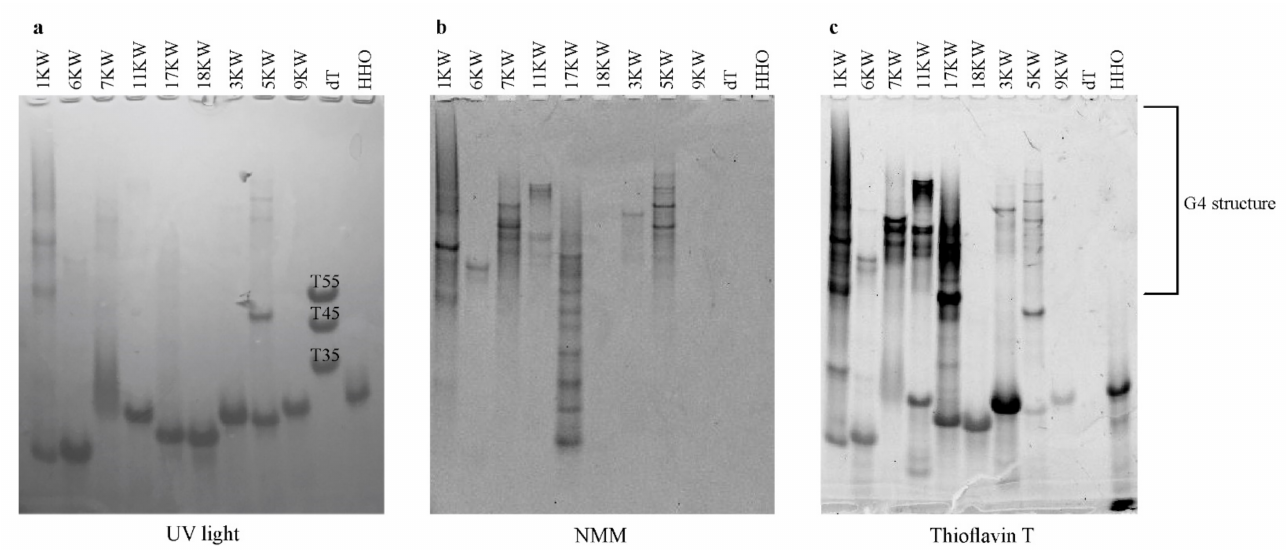
Figure 5. Visualization of model PQS oligomers migration on a native gel. ( a ) The gel under the UV light, ( b ) The gel after staining with G4 specific ligand, N-methyl mesoporphyrin IX (NMM), ( c ) The gel after staining with G4 specific ligand, thioflavin T. On the gels single-stranded dT is a mobility marker and hammerhead ribozyme (HHO) is a negative